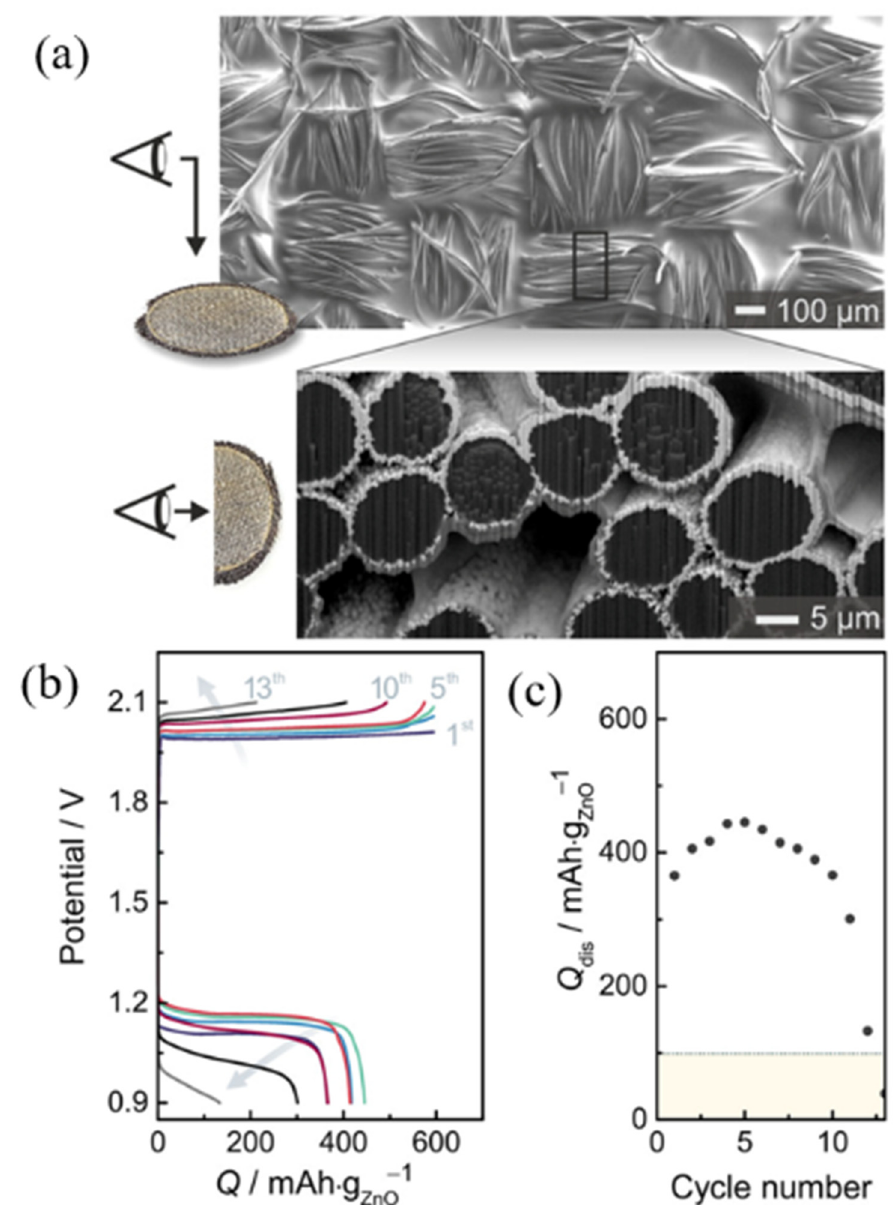
Figure 11. ( a ) SEM micrograph of FAA3–modified ZnO/C anode. The FAA3 is evenly distributed and coated over every carbon filament. ( b ) Charge/discharge profiles (in each cycle, charge and discharge curves are displayed with same color) ( c ) Specific discharge capacity Q dis (derived using the electrodeposited mass of ZnO) with an averaged DoD of 53.6% for 13 cycles [53]. Reprinted with permission from Ref. [53], Copyright 2018, American Chemical Society.